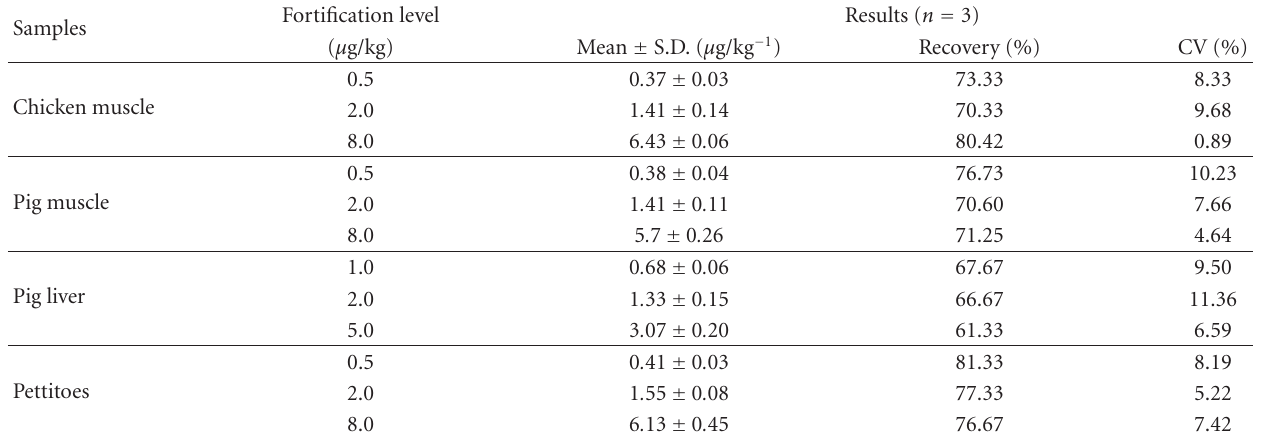
Table 3: Recovery studies of 4 samples at 3 levels by ELISA.